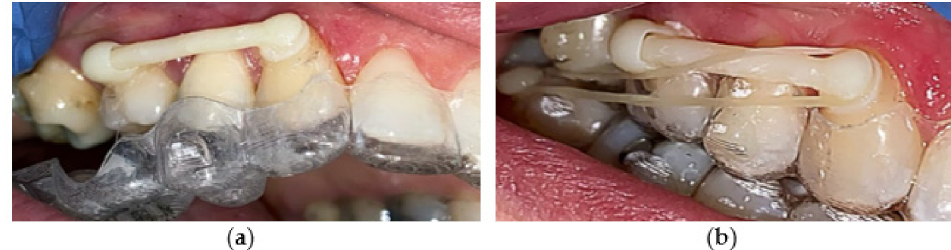
Figure 16. 3D printed distalizer. ( a ) fixed distalizer in hybrid treatment with CAT (Invisalign ® ); before activation; ( b ) fixed distalizer in hybrid treatment with CAT (Invisalign ® ); after